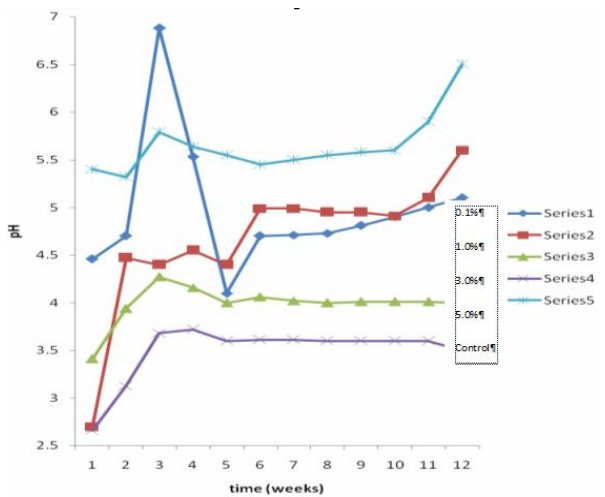
Fig. 6. Changes in the pH of varying concentrations of sodium acetate preserved powder of mango seed kernels stored at room temperature for 12 weeks. Each reading represents an average of 3 determinates